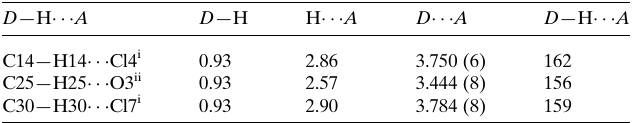
Table 1 Hydrogen-bond geometry (A˚ , (cid:2)